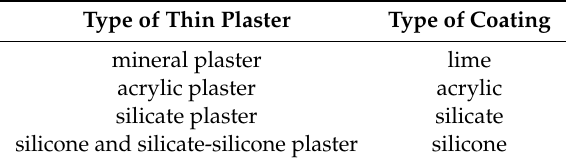
Table 4. Coating types associated with the individual plaster types (texture not taken into consideration).